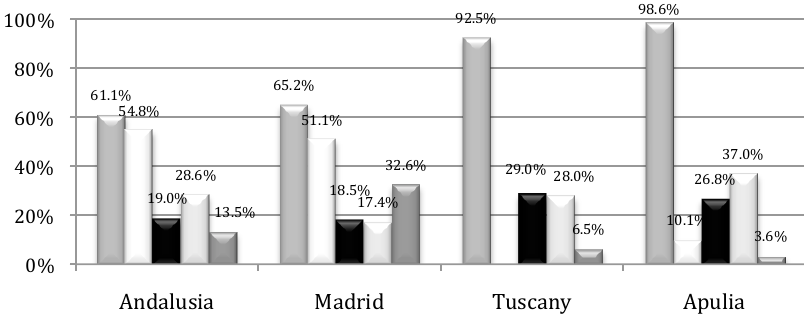
Graph 4. Breakdown of participants in participative experiences, by